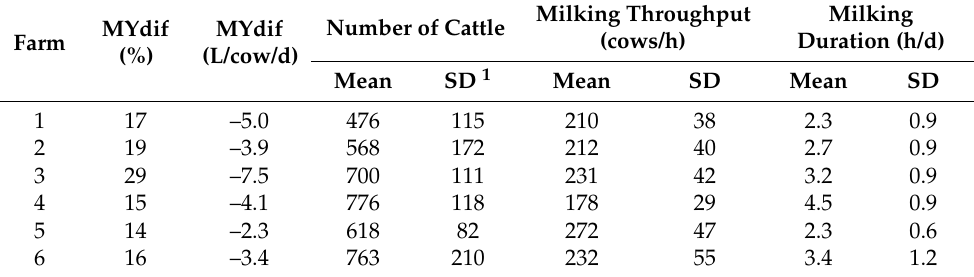
Table 3. Milk throughput (cows/hour), milking duration (hours/day), and milk yield difference (MYdif) between the first 50 and last 50 cows for each of the 6 farms. MYdif MYdif Farm (L/cow/d)